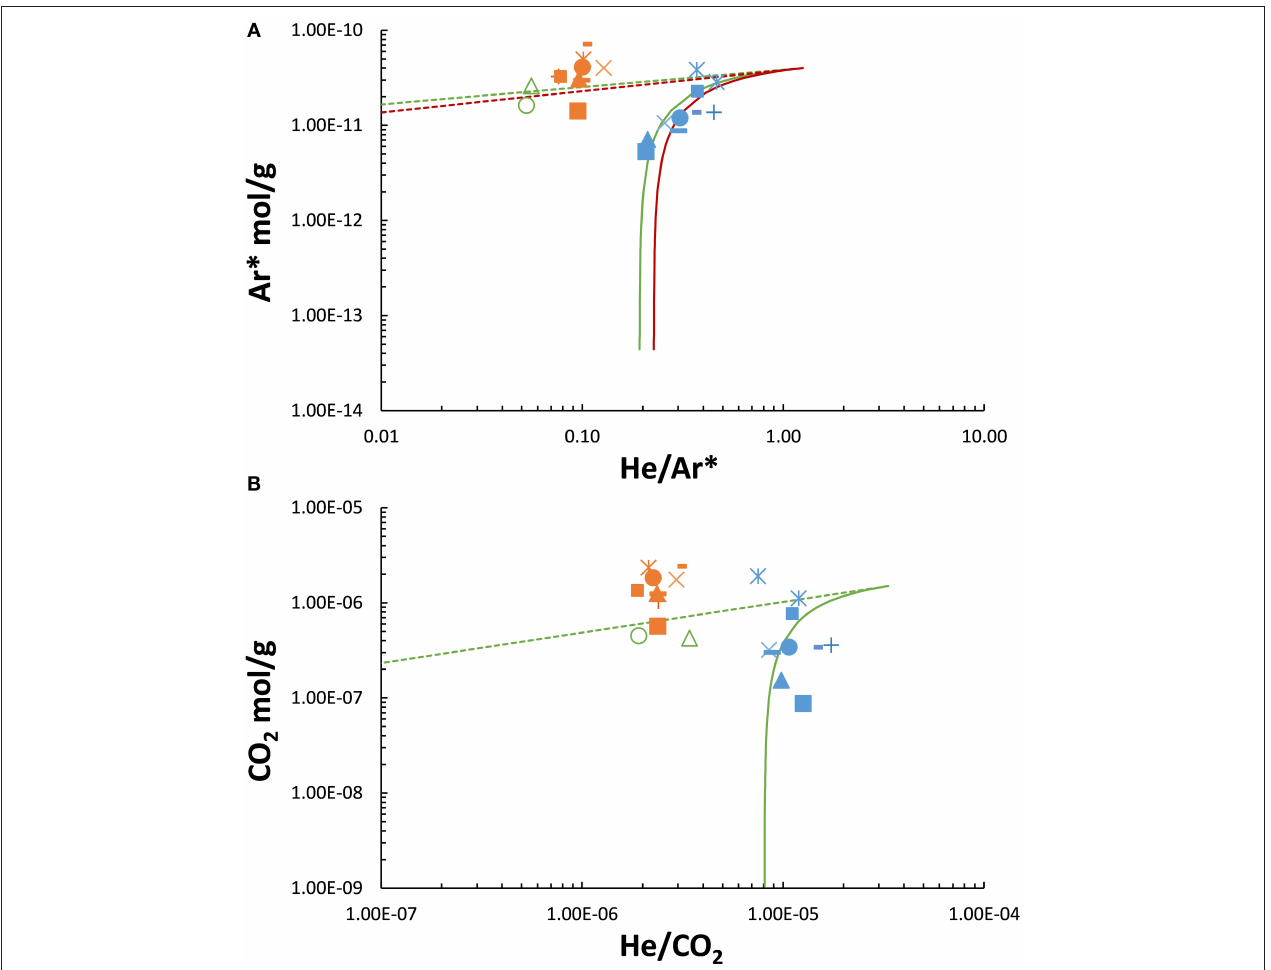
FIGURE 11 | (A) He/Ar* vs. Ar* concentration and (B) He/CO 2 vs. CO 2 concentration. The modeling of the modal batch and fractional equilibrium melting and starting conditions are the same as in Figure 9 . The symbols are the same as in Figure 9 .